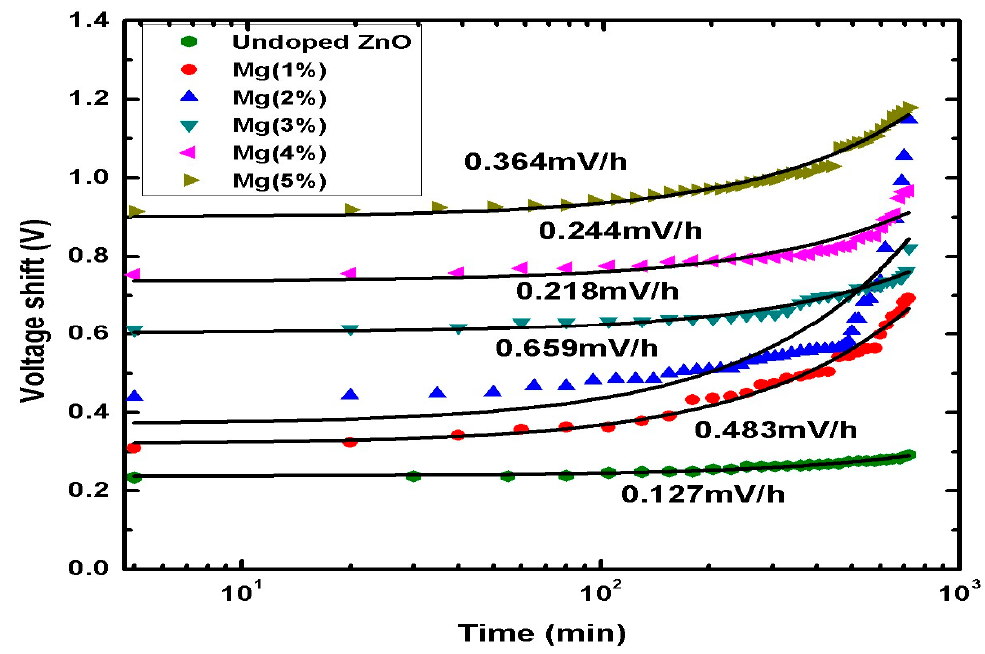
Figure 10. The drift rate of undoped ZnO and Mg-doped ZnO nanorod sensing membranes at different contents of Mg.